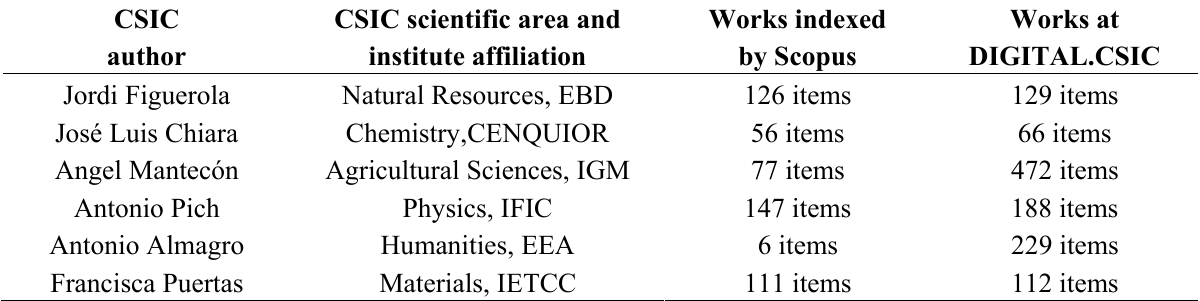
Table 3. Selected OA friendly authors across all CSIC scientific areas and presence of their outputs in Scopus and